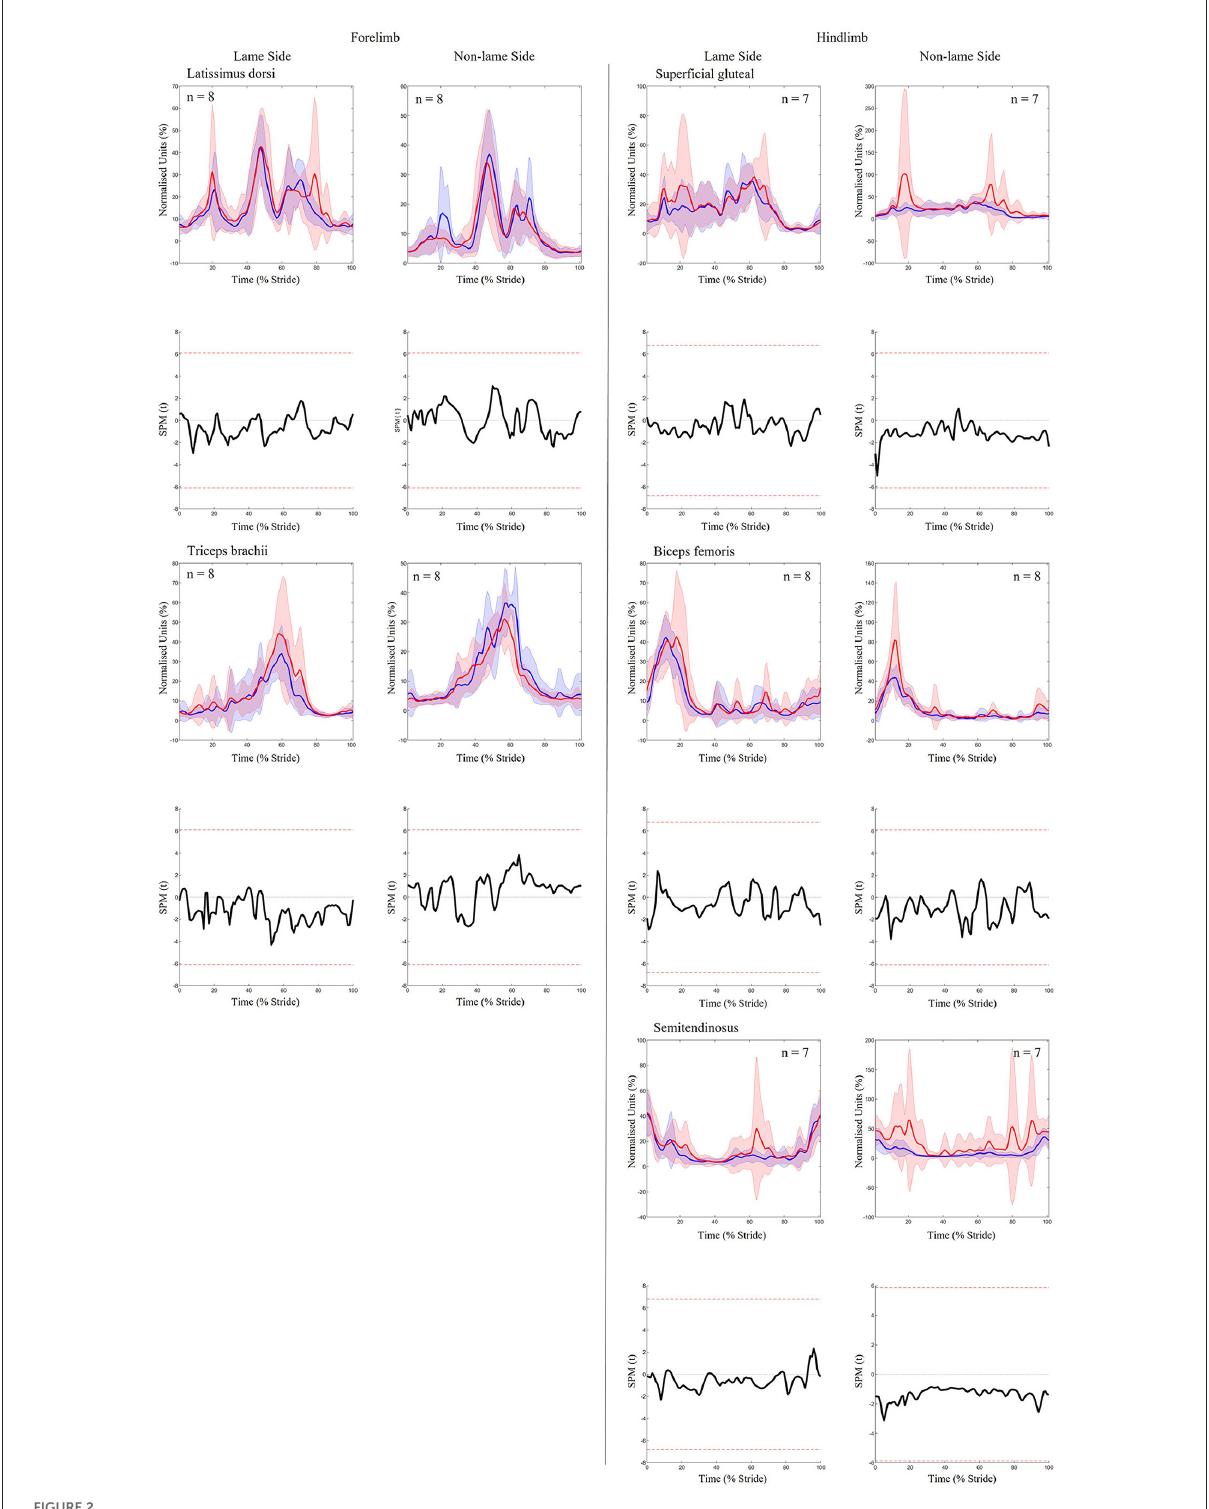
FIGURE2 SPM results for time- and amplitude-normalized sEMG data across the group of horses (n = 8) for studied superficial muscles of the forelimb (Left panel) and hindlimb (Right panel) during baseline 1 (blue solid lines/shaded area) and induced forelimb lameness (red solid